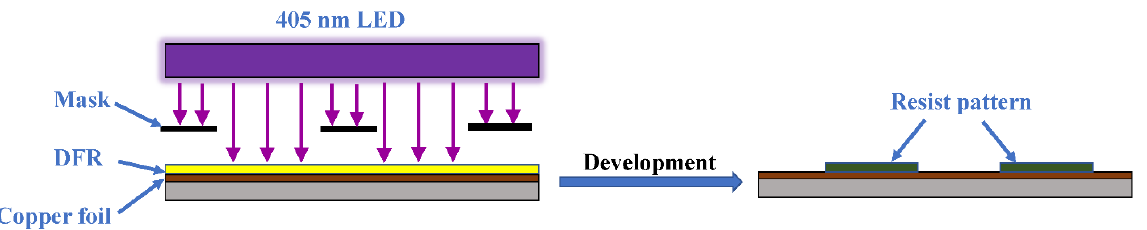
Figure 2. Photolithography procedure involving the use of DFRs for preparing a printed circuit